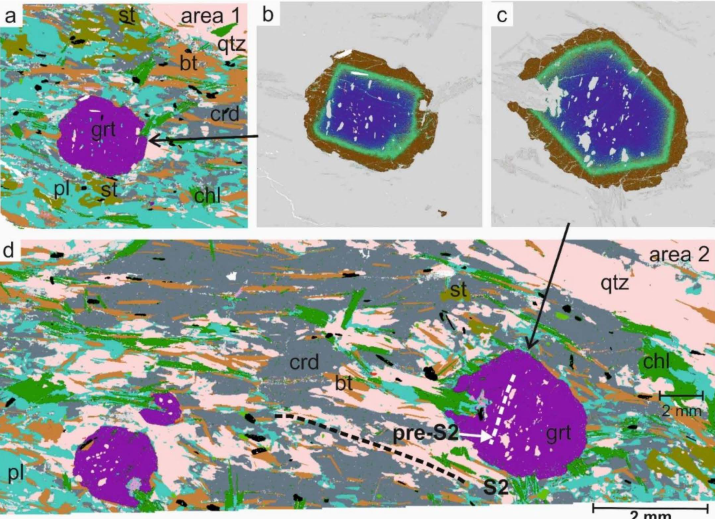
Figure 6. QEMSCAN images of A-type garnet in the thin section TTKI-2005-14.2. The image of the whole thin section is shown in Supplementary Materials Figure S4. ( a ) False colour QEMSCAN mineral map showing a garnet and matrix. ( b ) False colour QEMSCAN mineral map showing the zoning in the garnet from image ( a ). ( c ) False colour QEMSCAN mineral map showing the zoning in the garnet from image ( d ). ( d ) False colour QEMSCAN mineral map showing the S2 foliation in the matrix and garnet from image ( c ) For the compositional di ff erences, causing the zoning in the two upper right figures, see Figure